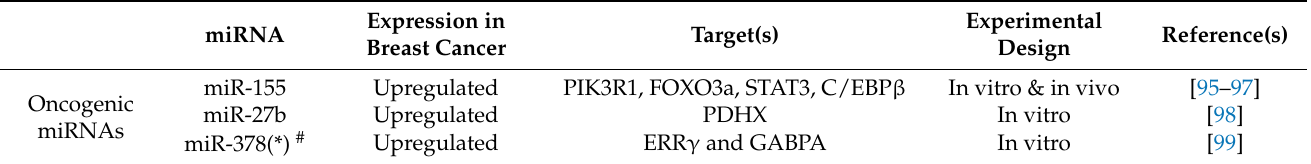
Table 3. miRNAs regulating the Warburg